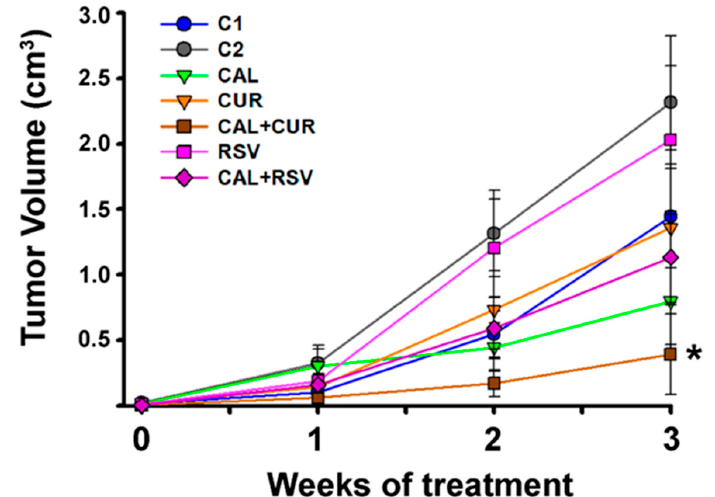
Figure 4. In vivo effect of calcitriol, curcumin, resveratrol, or the co-treatments in tumor volume. MBCDF-T cells were xenografted in female nude mice. Treatments started the following day and lasted 3 weeks. Mice were treated with saline solution (C1), vehicle (C2), calcitriol (Cal), curcumin (Cur), resveratrol (Rsv), or the combination of calcitriol with resveratrol (Cal + Rsv) or with curcumin (Cal + Cur). * p < 0.05 vs. C1 and C2. N ≥ 9, mean ± SEM.